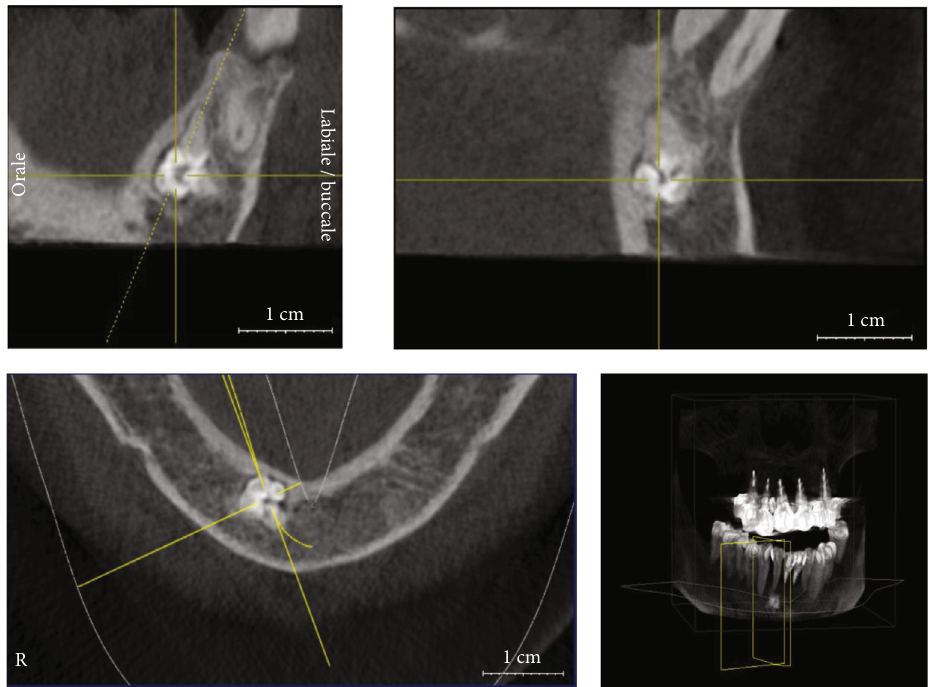
Figure 1: The image shows the size of the lesion in the CBCT scan approximately 10 years before its removal.